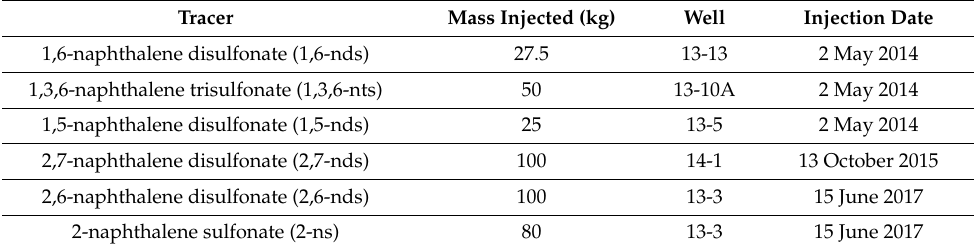
Table 1. Tracer injection parameters. Well locations shown in Figure